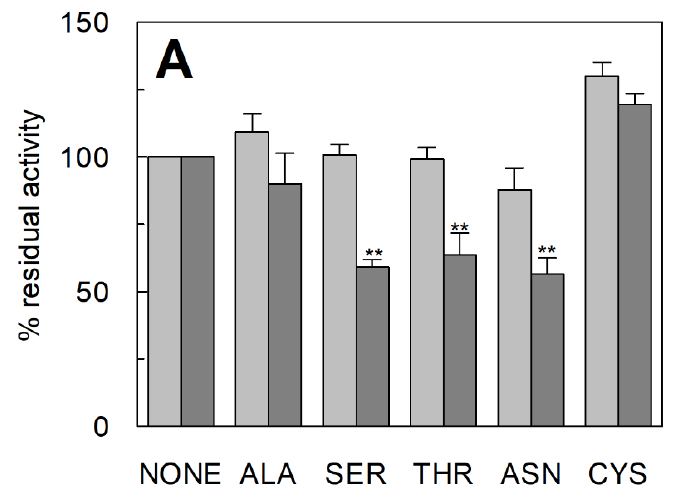
Figure 2. Dependence on cholesterol of the [ 3 H]-glutamine unidirectional transport by ASCT2 WT and C467A mutant in proteoliposomes. Purified WT (light grey) and C467A (dark grey) proteins were reconstituted in proteoliposomes prepared with the indicated amounts of cholesterol per mg phospholipids, as described in Materials and Methods. The transport was started by adding 500 µM [ 3 H]-glutamine in the presence of 50 mM Na-gluconate to proteoliposomes; the transport was stopped after 30 min according to the stop inhibitors method. The transport activity was calculated as percent of residual activity with respect to condition without cholesterol. * Significantly different from the control sample as estimated by Student’s t -test ( p < 0.05) .